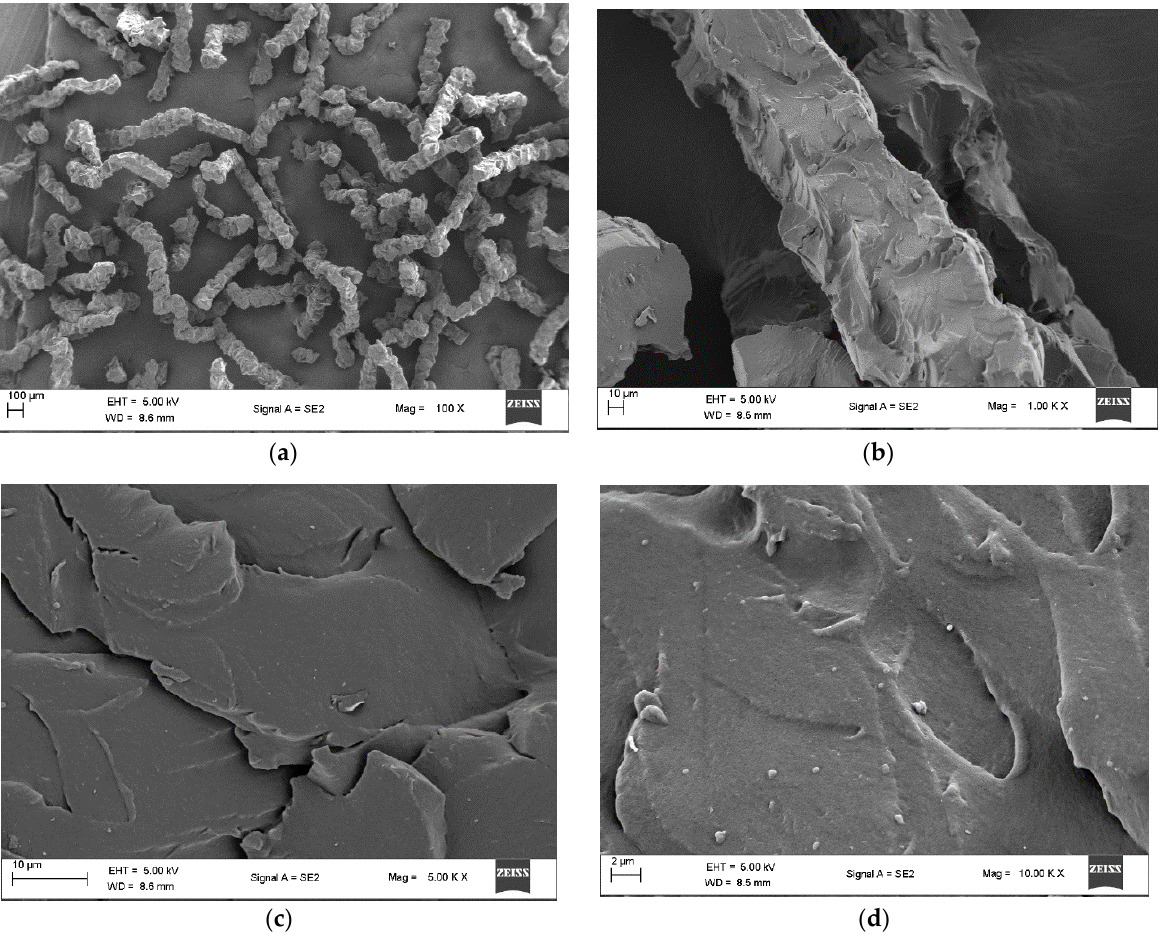
Figure 2. SEM images of amino-Li-resin: ( a ) 100 µm (100 X), ( b ) 10 µm (1.00 K X), ( c ) 10 µm (5.00 K X), and ( d ) 2 µm (Mag = 10.00 K X).